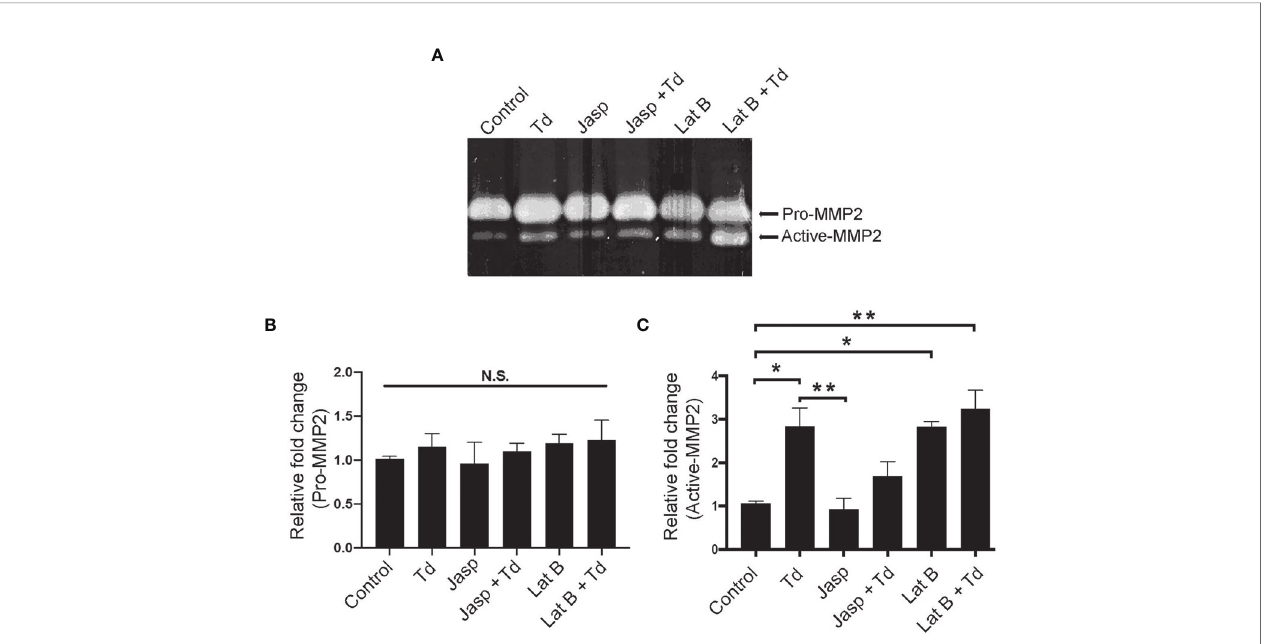
FIGURE 7 | Actin depolymerization through T. denticola challenge and Latrunculin B pretreatment increases MMP-2 enzymatic activity. Actin polymerizing agent Jasplakinolide (Jasp) and actin depolymerizing agent Latrunculin B (Lat B) were used to pretreat PDL cells for one h. Cells were then unchallenged or challenged with T. denticola (50 MOI) for 24 h. Cultured media was collected and gelatin zymography was used to measure MMP-2 activity. A representative Gelatin zymogram is shown (A) and densitometry analysis of pro-MMP-2 (B) and active-MMP-2 (C) . Data represent mean ± SD from three independent experiments. Data were compared using One-way ANOVA Tukey ’ s Multiple comparisons test. *. = p<0.05; ** = p<0.01; N.S., not signi fi